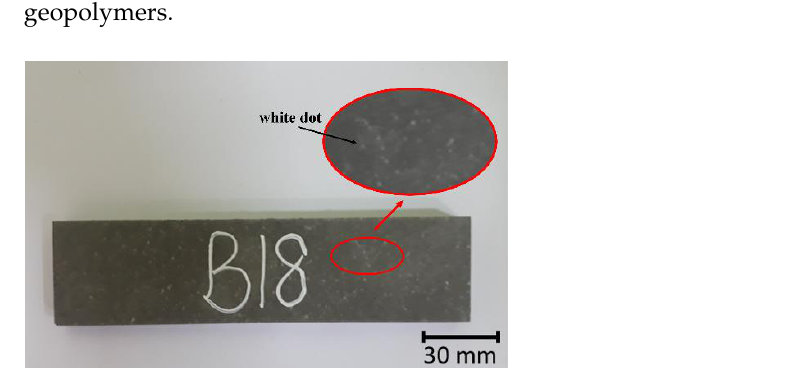
Figure 5. Surface condition of FAB geopolymer with magnified view of white dots in the red circle area.